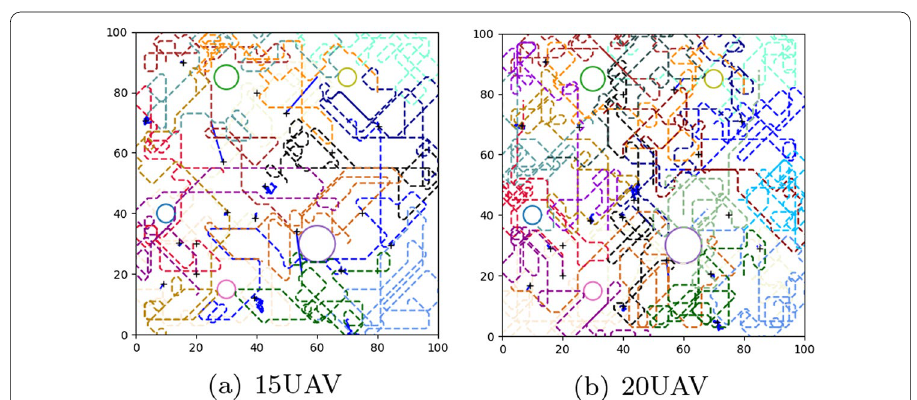
Fig. 6 Different number of UAVs’ paths generated after 250 iterations for the mission with